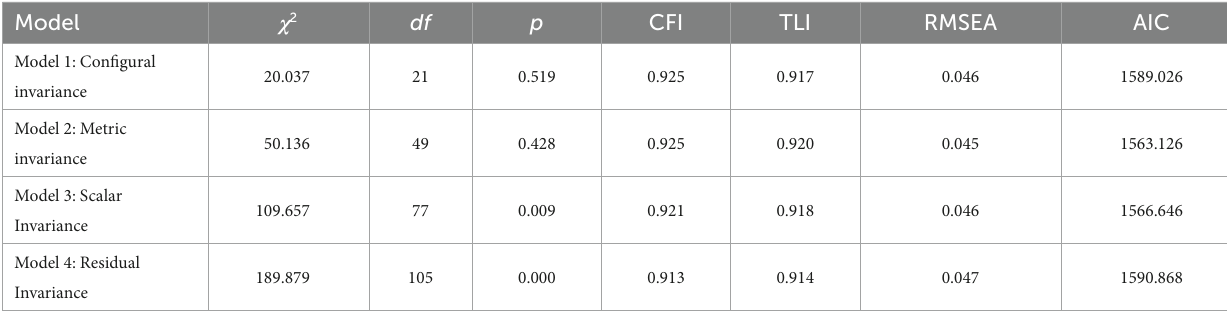
TABLE 5 Results of measurement invariance assessment ( N =